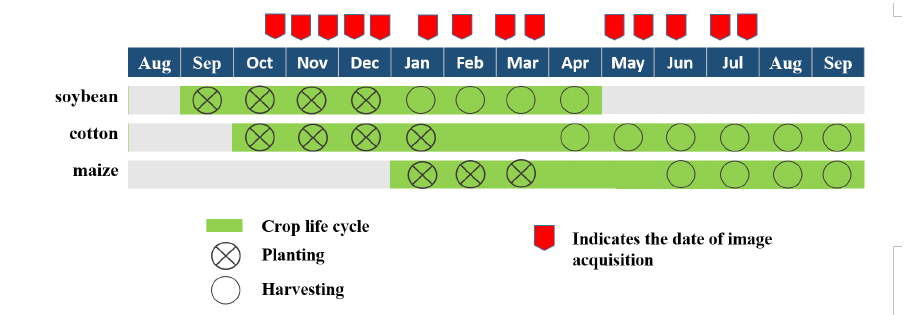
Figure 5. Crop calendar for major crops in Campo